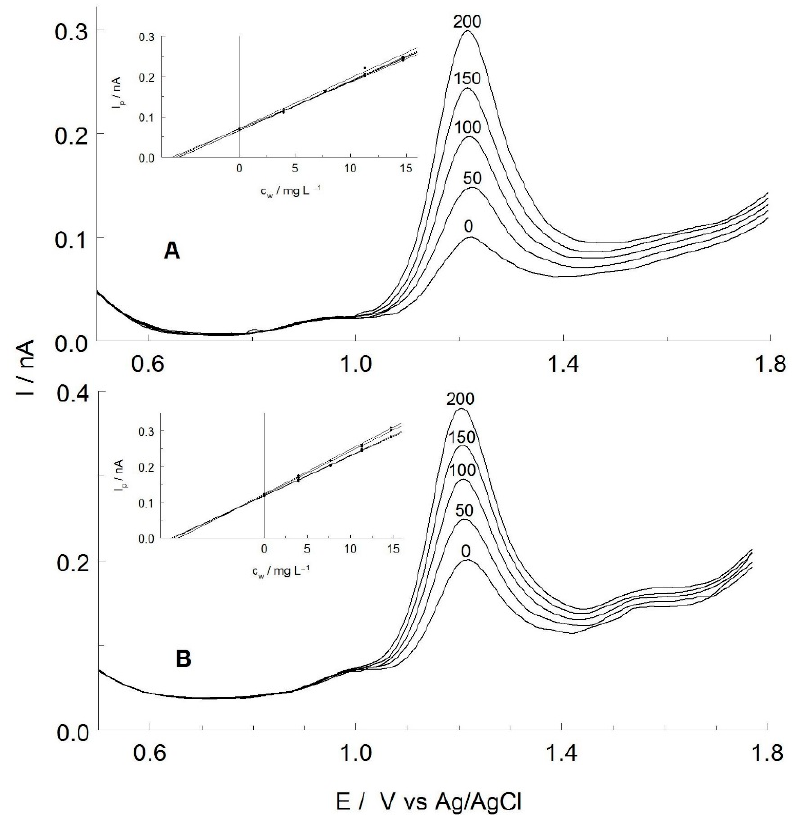
Figure 5. DPV curves recorded ( A ) in control solution of thymol (5.32 µg mL − 1 ) with rosemary extract (30 µL/mL) and ( B ) in solution containing thyme extract (30 µL/mL) and after additions of THY standard solution (c = 162 µg mL − 1 , the volumes in µL are given at curves). Insets: calibration curves in the standard addition method for the control and spices sample,